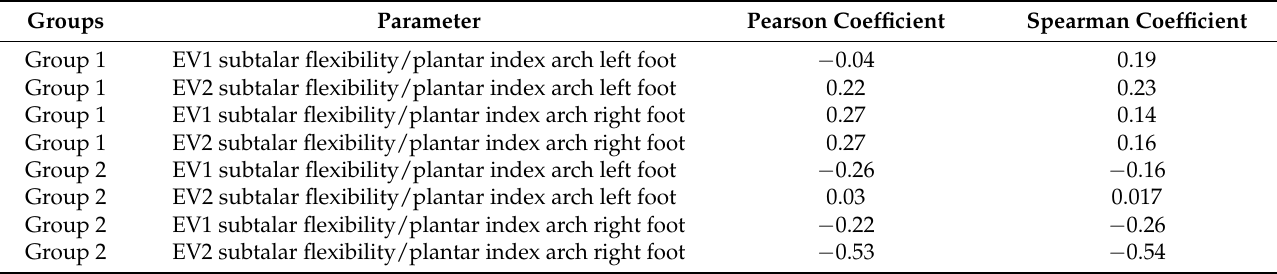
Table 8. Person and Sperman correlation coefficients.